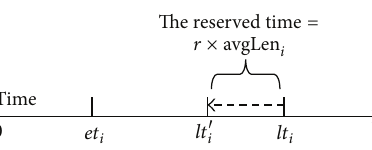
Figure 1: An illustration of advancing 𝑙𝑡 𝑖 to 𝑙𝑡 󸀠 𝑖 for customer 𝑖